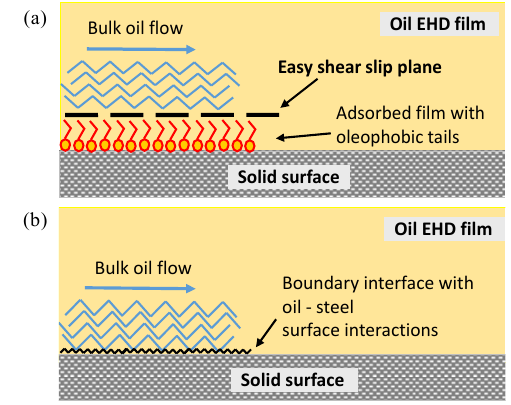
Schematic presentation of the mechanism for (a) easy shear slip plane between the oleophobic alkyl chain tails and bulk oil film, compared to (b) direct interaction between the oil and the steel surface (commonly oxidised, with contaminants), absent of easy-shear